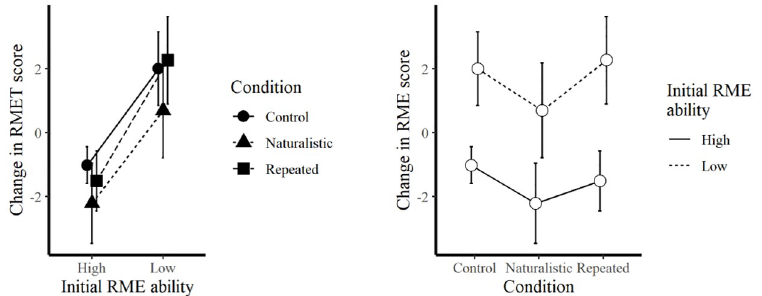
Fig 2. Difference in mean change in RMET score by condition and initial RME ability. Error bars represent 95% Confidence Intervals.